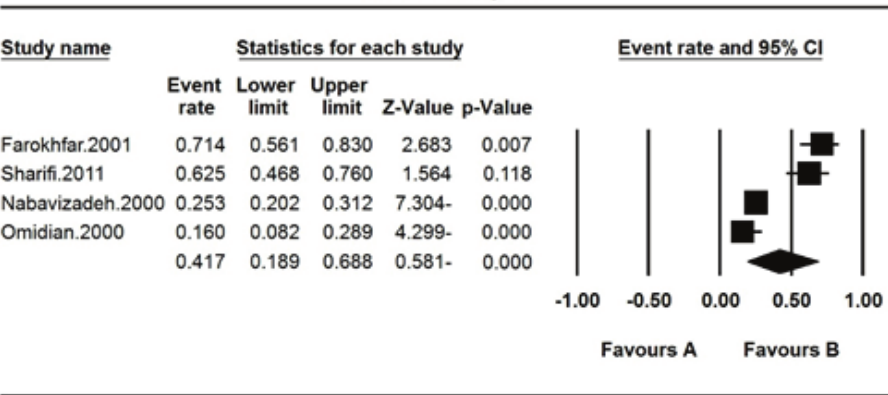
Figure 5. The prevalence of red–green color blindness (Tritan) in Iranian students.